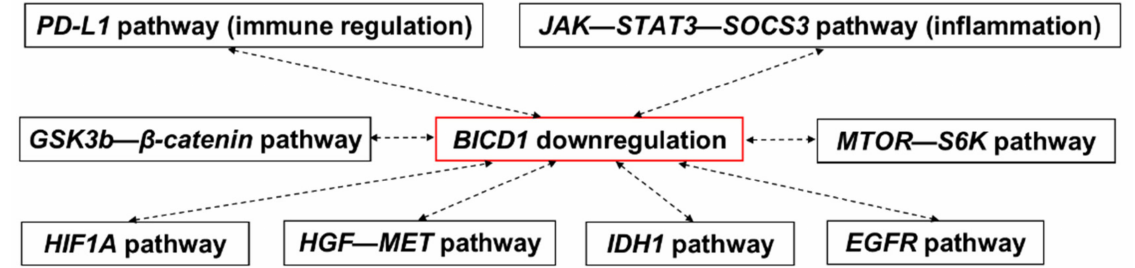
Figure 8. Possible pathways associated with BICD1 downregulation in LGGs. A summary of the high correlations between BICD1 downregulation and several well-known pathways associated with cancer